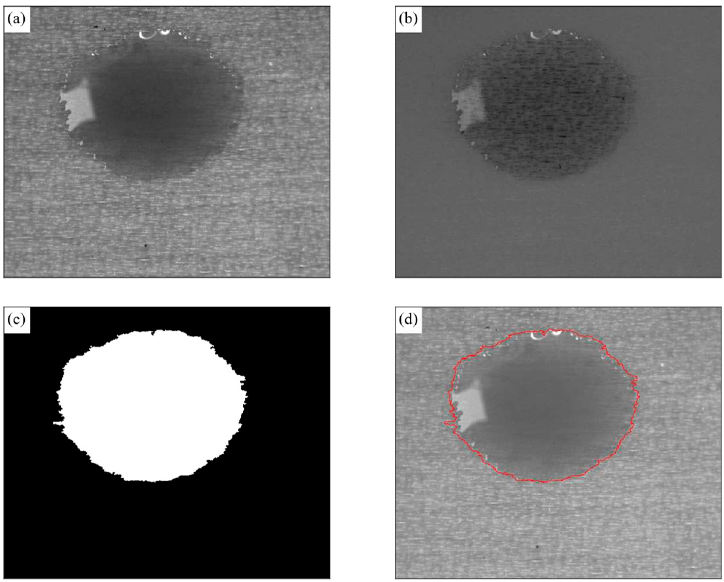
Figure 9. Droplet image processing using the calibration subtraction method at various steps: ( a ) grayscale, ( b ) subtraction, ( c ) filtered, and ( d ) boundary traced.